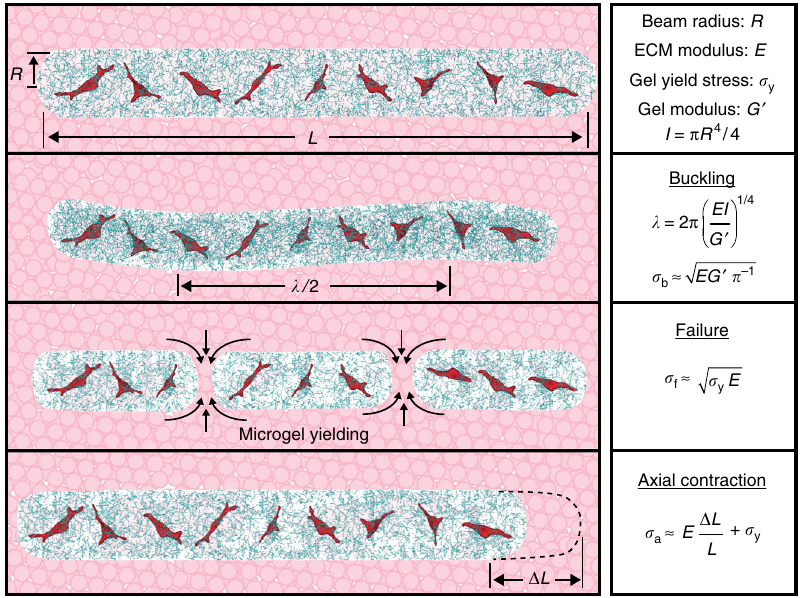
Fig. 6 Summary of cell – ECM microbeam mechanics. By varying microbeam parameters and the material properties of the microgel medium, we observe a series of transitions between straight beams (top panel), buckled beams (second to top panel), broken beams (second to bottom panel) and axially contracted beams (bottom